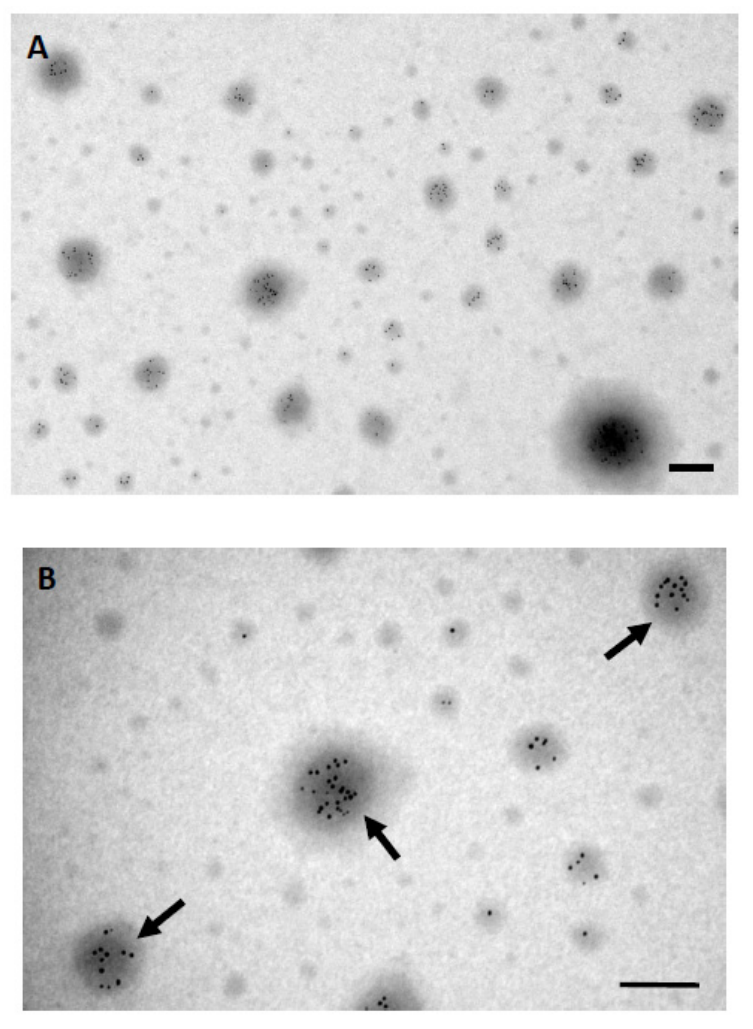
Figure 4. Immunoelectron micrographs of isolated platelet granules in the microchip. ( A ) This picture shows that the 6-nm gold particle-labeled granules are α -granules, because P-selectin is located on the surface of these granules. The other vesicles not significantly labeled by gold particles might be lysosomes or exosomes. ( B ) The gold particles labeled granules were shown in higher magnification. There are abundant gold particles located on the surface of α -granules (indicated by arrows). Scale bar, 0.2 μ m.